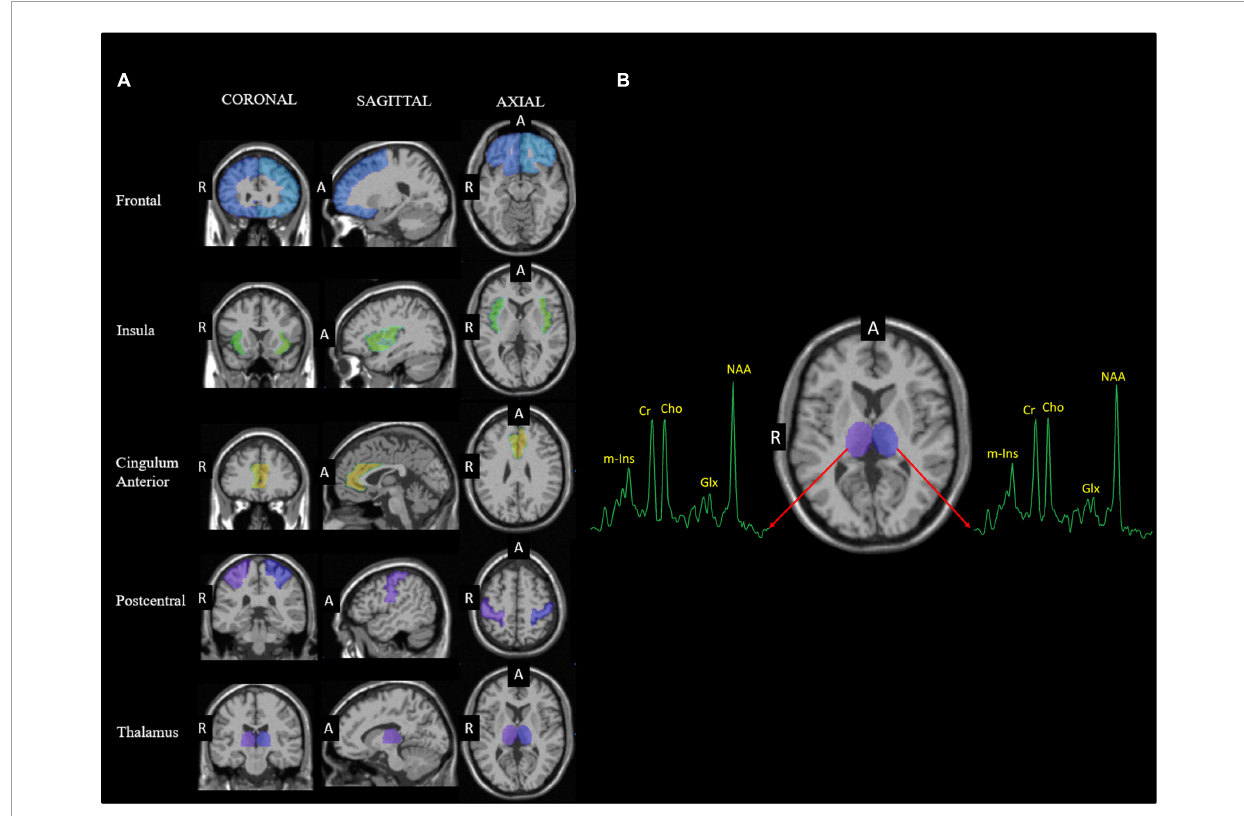
FIGURE1 (A) Coronal, sagittal and axial slices showing the regions of interest (ROIs), including the frontal, cingulum anterior, insula, postcentral, and thalamus from left and right hemispheres, superimposed on template T1 MRI and obtained using the AAL atlas (63). (B) Representative spectrum from the thalamus. Abbreviations used for anterior (A) and right